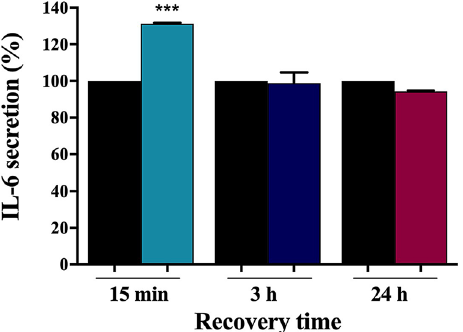
Figure 2. IL-6 secretion analysed by ELISA test in cultured media of HaCaT cells exposed for 1 h to 1 MHz US at I spta = 65 mW/cm 2 followed by different post-treatment recovery times. The control samples (black histograms) were maintained in the same environmental conditions of treated samples for an amount of time corresponding to exposure time. US stimulus drove a quick cytokine release at 15 min from the exposure. The reported values and error bars represent the average and the standard deviation evaluated on each sample analysed. Asterisks indicate significant difference from control samples (*** p < 0.001). The graph is representative of at least three independent